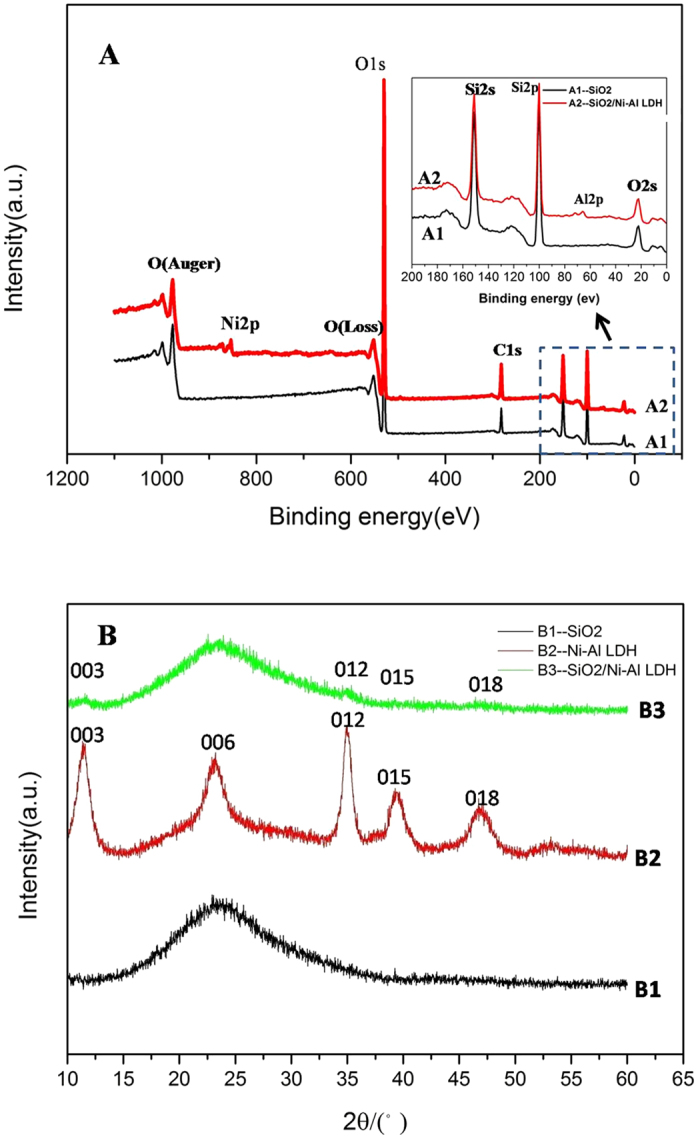
(A) XPS survey spectra of SiO2 sphere and SiO2@Ni–Al LDH composites. (B) XRD patterns of SiO2 sphere, Ni−Al LDH sheet, and SiO2@Ni-Al LDH composites, respectively.